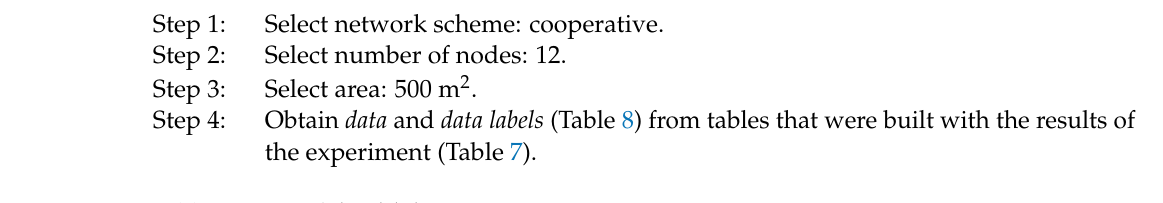
Table 8. Data and data labels.